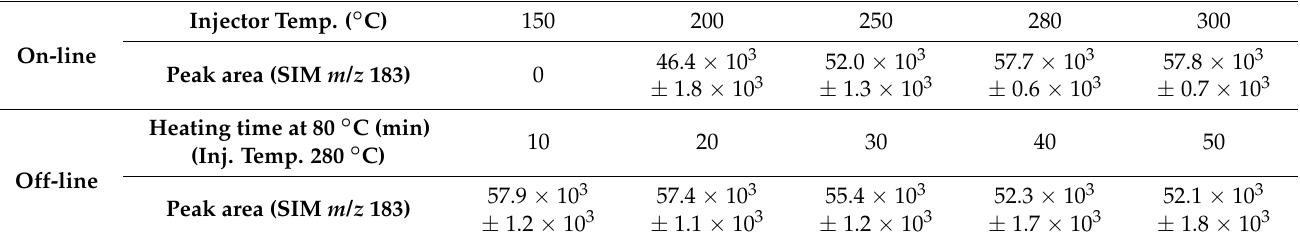
Table 2. Comparison of efficiency of on-line and off-line derivatization of 50 ng/mL PAT in ACN ( n = 5) prior to GC −